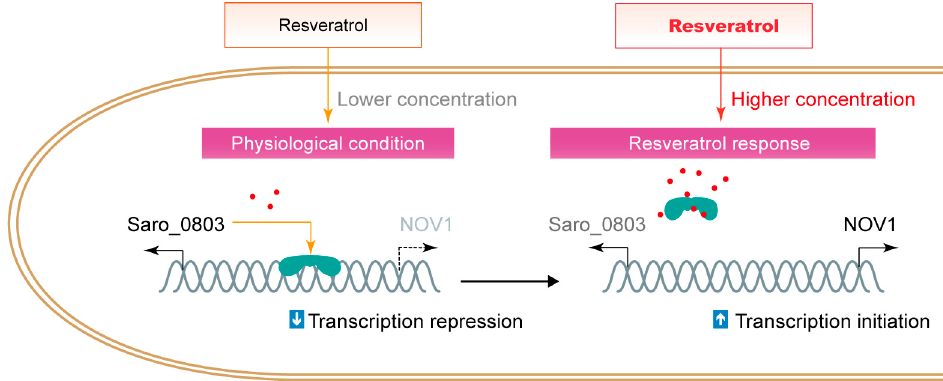
Figure 6. The schematic illustration of the interference of resveratrol to the repression of Saro_0803 to nov1 .